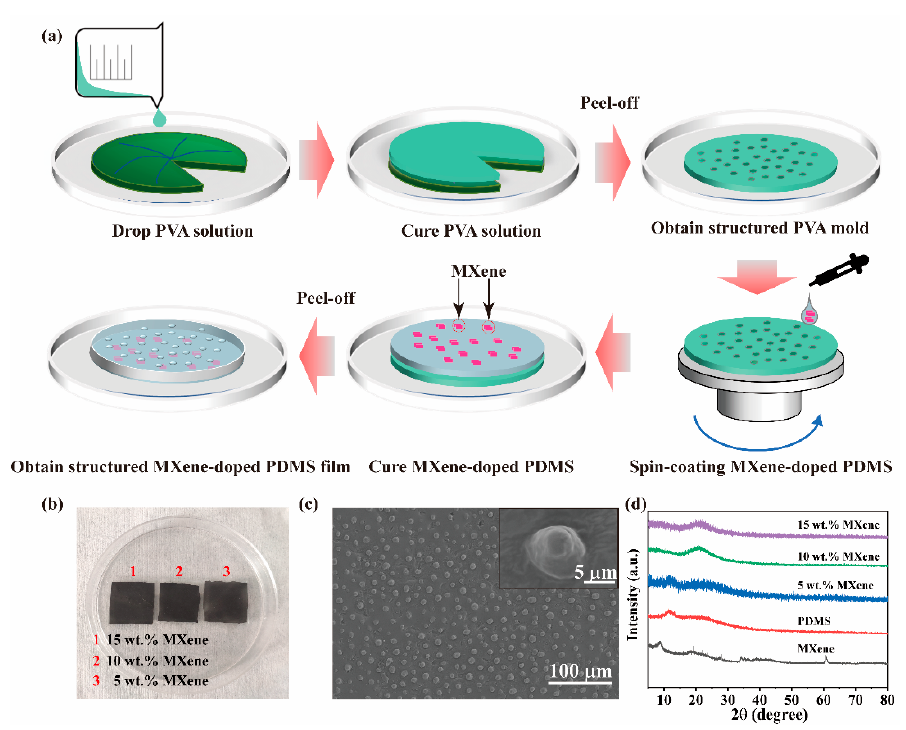
Figure 1. ( a ) Schematic diagram for preparation of structured MXene-doped PDMS film. ( b ) Photo- graph of the as-prepared MXene-doped PDMS films. ( c ) Typical SEM image of the MXene-doped PDMS film (with 10 wt.% MXene). ( d ) XRD patterns of the MXene-doped PDMS films in comparison with the pure PDMS and MXene.